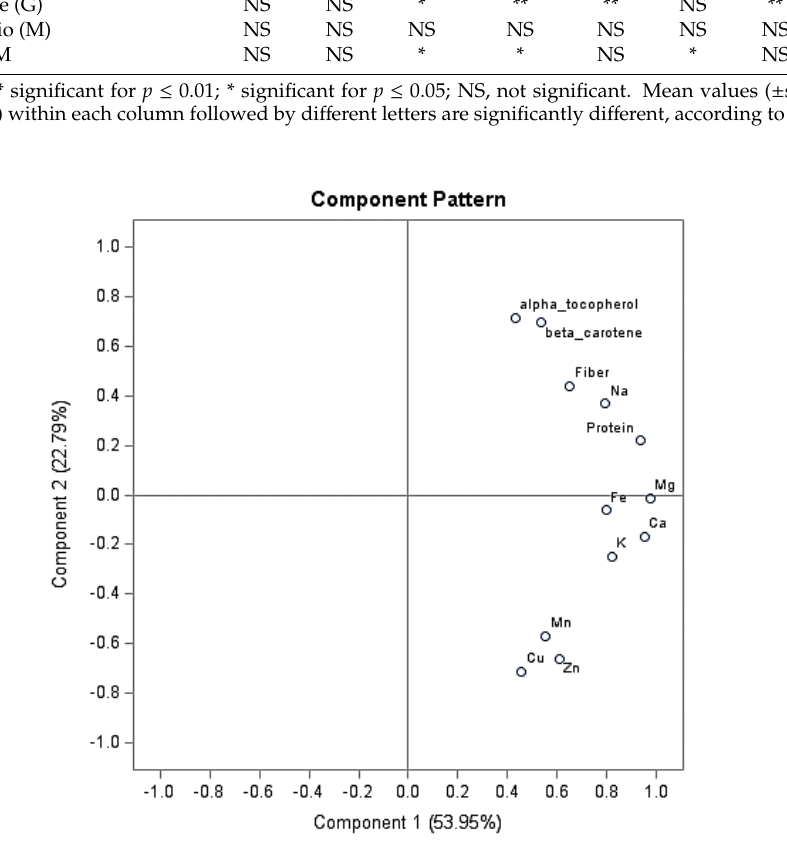
Micro cauliflower